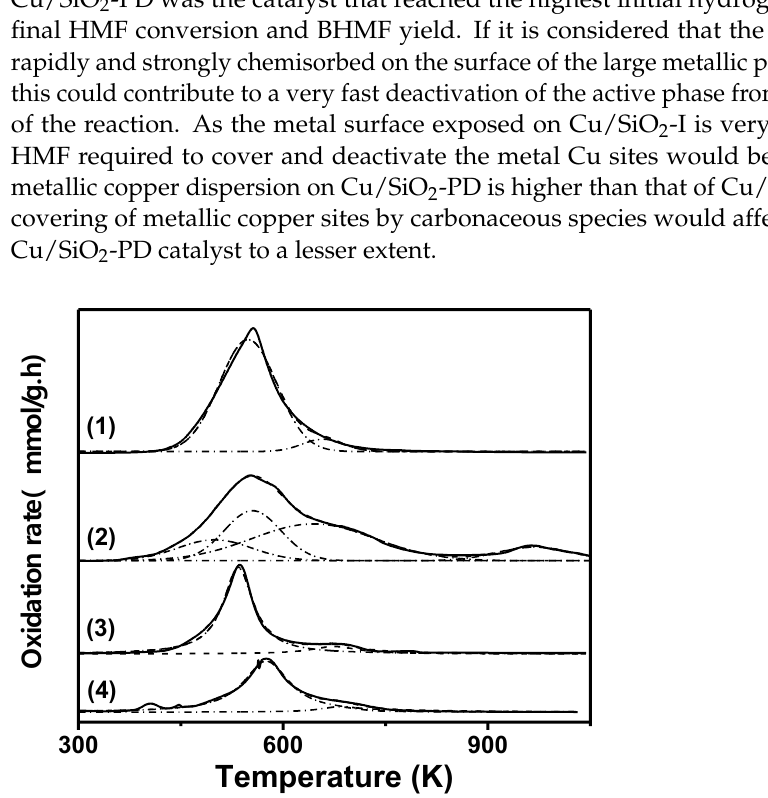
Figure 8. Catalytic performance of fresh, used and regenerated Cu/SiO 2 -PD in the liquid-phase HMF hydrogenation at T = 393 K, P H2 = 15 bar, C 0HMF = 0.13 M: (a) fresh catalyst, (b) used catalyst, (c) after H 2 treatment at 523 K, (d) after air treatment at 673 K and subsequent reduction in H 2 at 523 K.